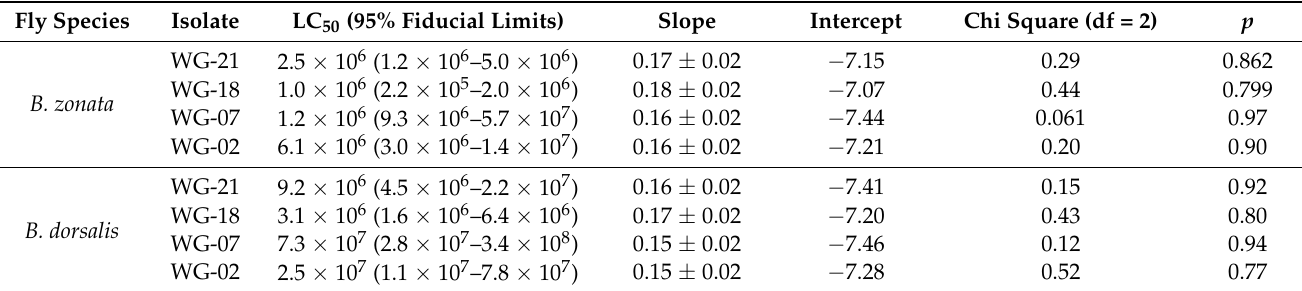
Table 3. Probit analysis estimates of lethal concentrations required to kill 50% (LC 50 ) of larvae of B. zonata and B. dorsalis along with their 95% fiducial limits. p value represents the goodness of fit test.